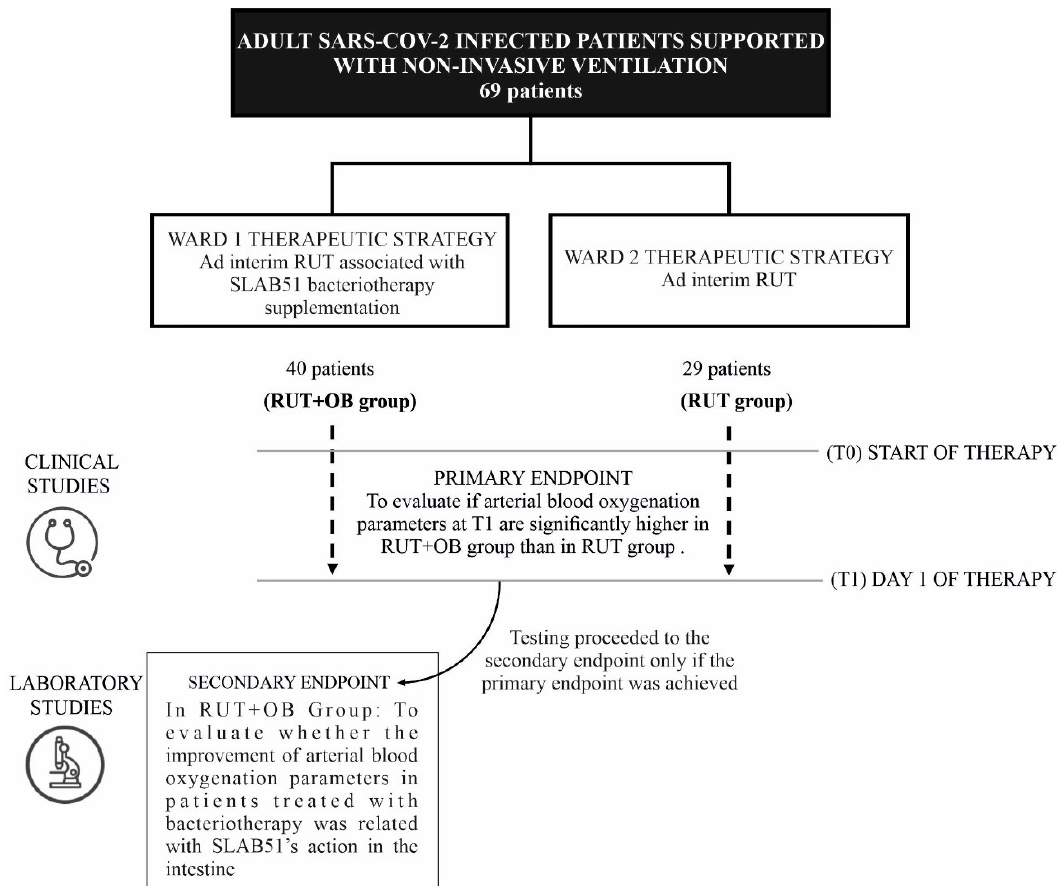
Figure 1. Schematic representation of the study design.